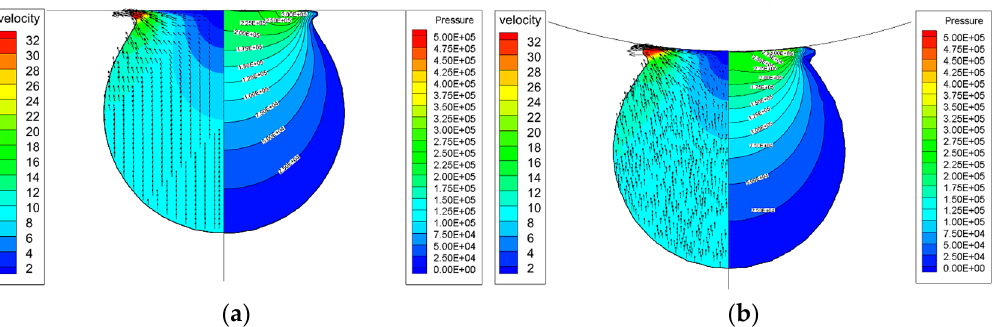
Figure 7. Distribution of velocity and pressure: ( a ) droplet impacting flat wire; ( b ) droplet impacting circular wire.